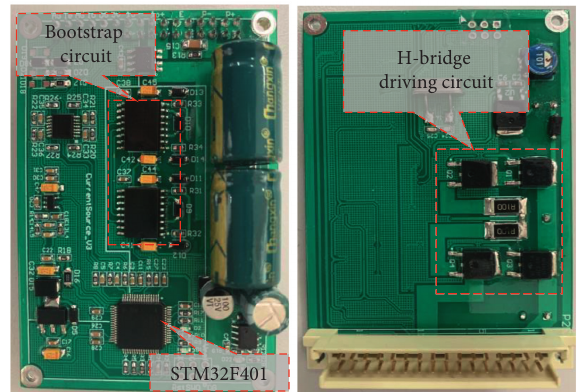
Figure 11: PCB circuit board.